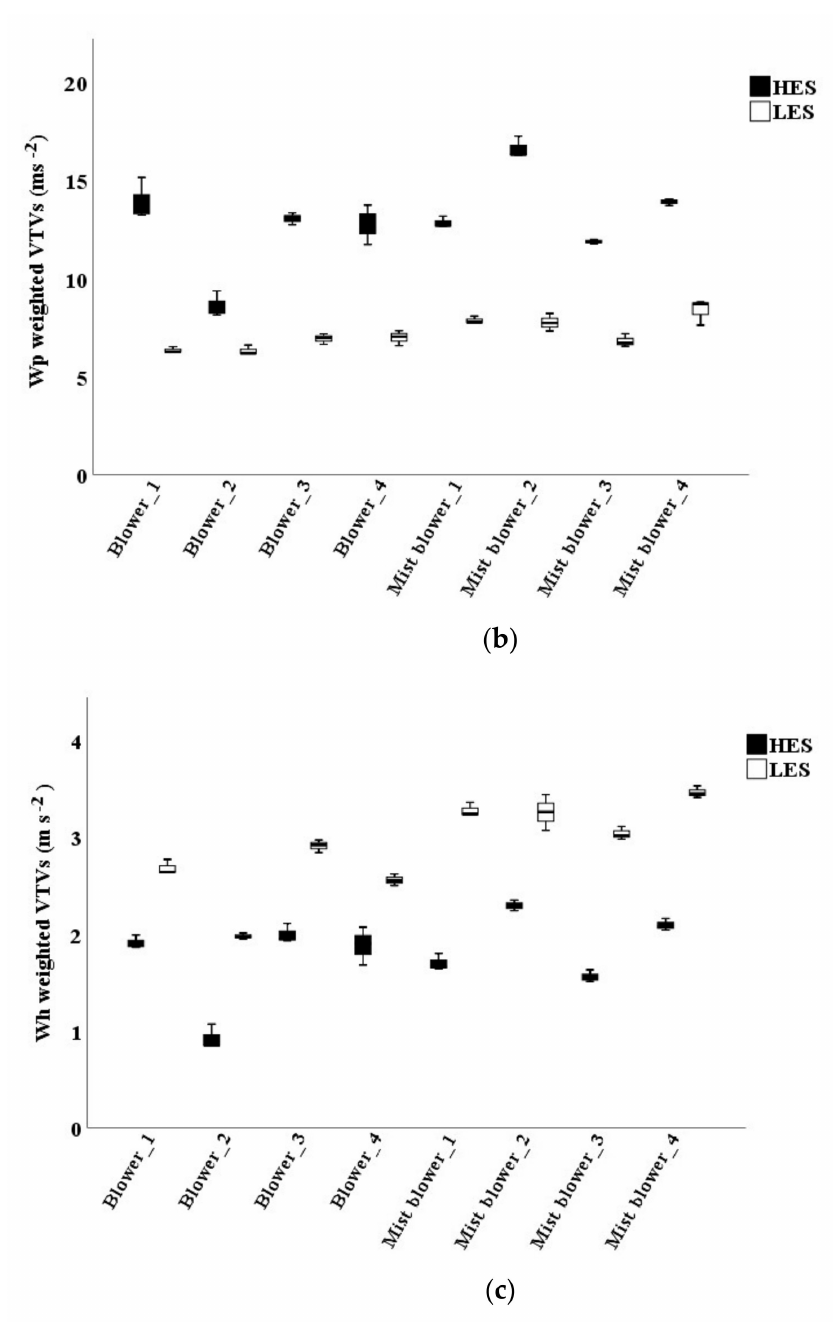
Figure 8. Vibration total values (VTVs) of the hand-arm system of the signals unweighted ( a ), W p weighted ( b ), and W h weighted ( c